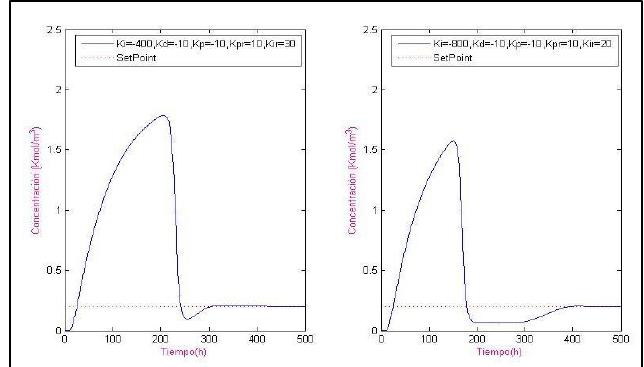
Figura 13: Respuesta transitoria del sistema para dos juegos de valores de las ganancias proporcional K , integral K y derivativa K p i d del controlador PID del reactor CSTR y las ganancias proporcional e integral K del controlador PI del Bioreactor continuo de K pr ir mezclado